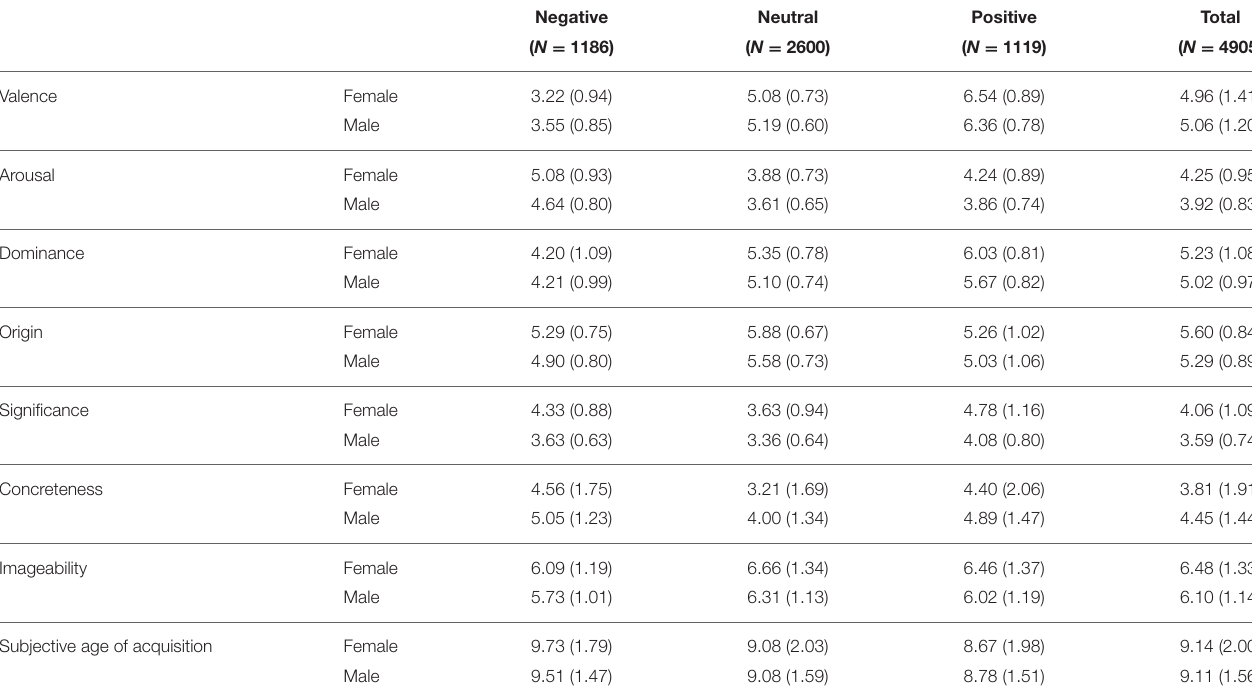
TABLE 4 | Mean assessments for female and male participants in case of each analyzed